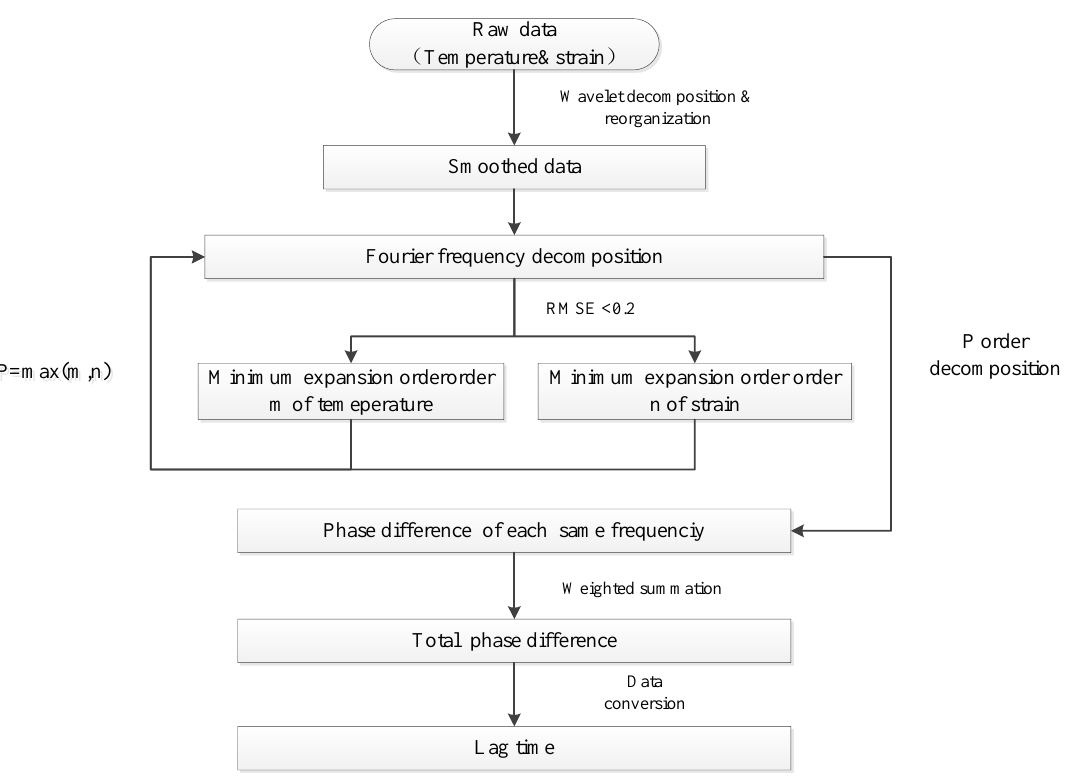
Figure 5. The flow chart of the Fourier series expansion.